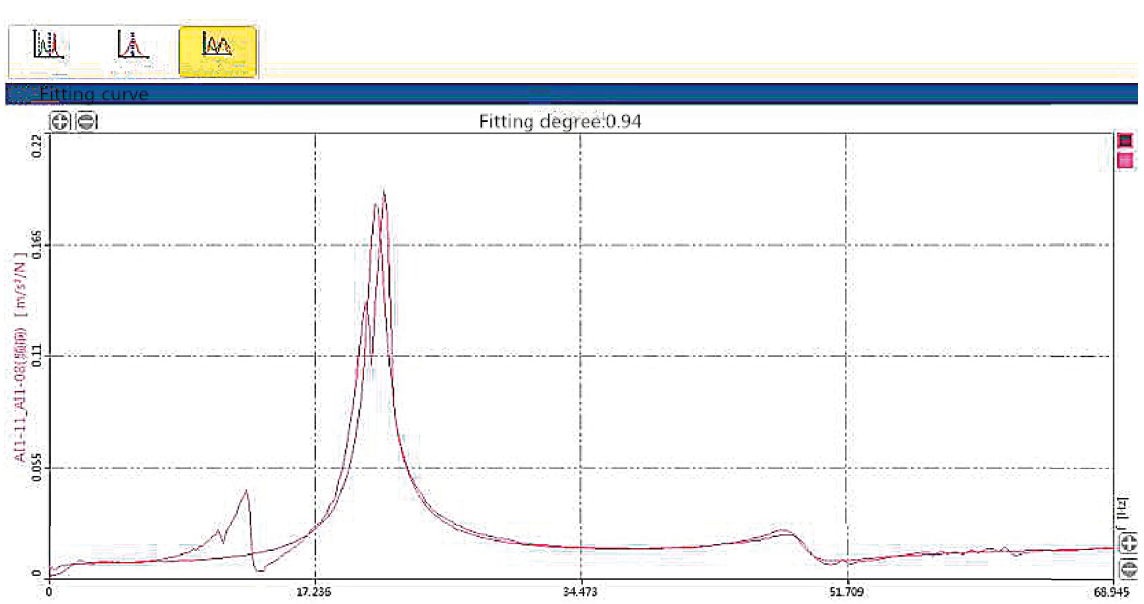
Figure 13: Frequency response curve